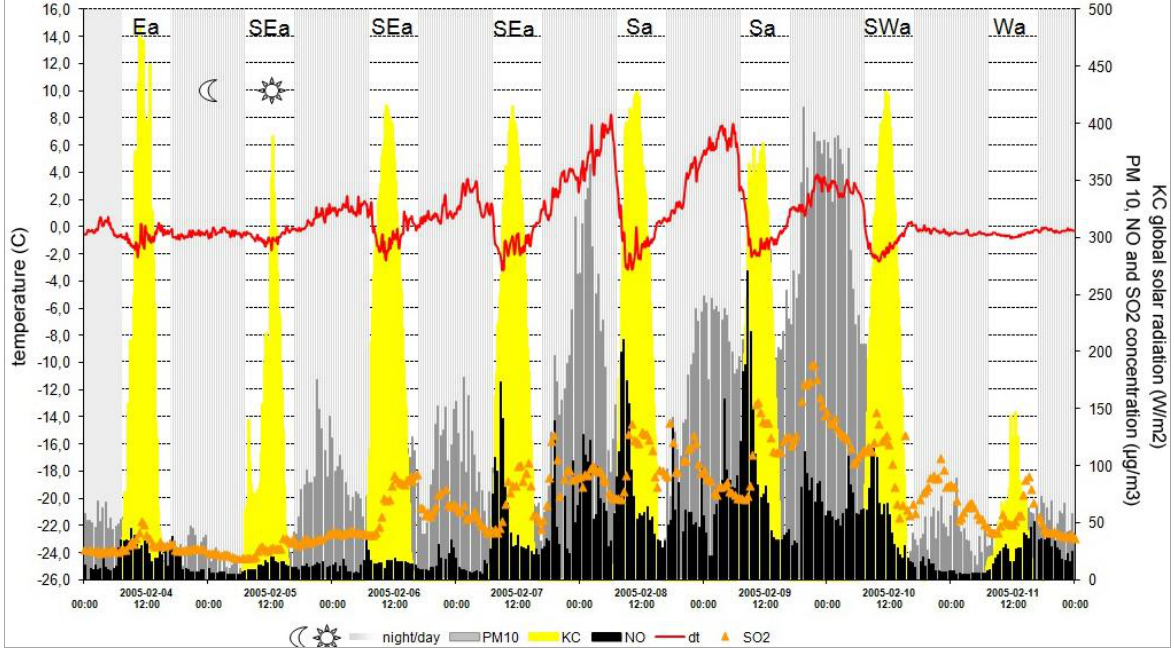
Fig. 7. Temperature differences (Δt) between 2 m a.s.l. and 100 m. a.s.l , PM 10, NO, SO 2 concentration and global solar radiation in Sosnowiec during the thermal inversion